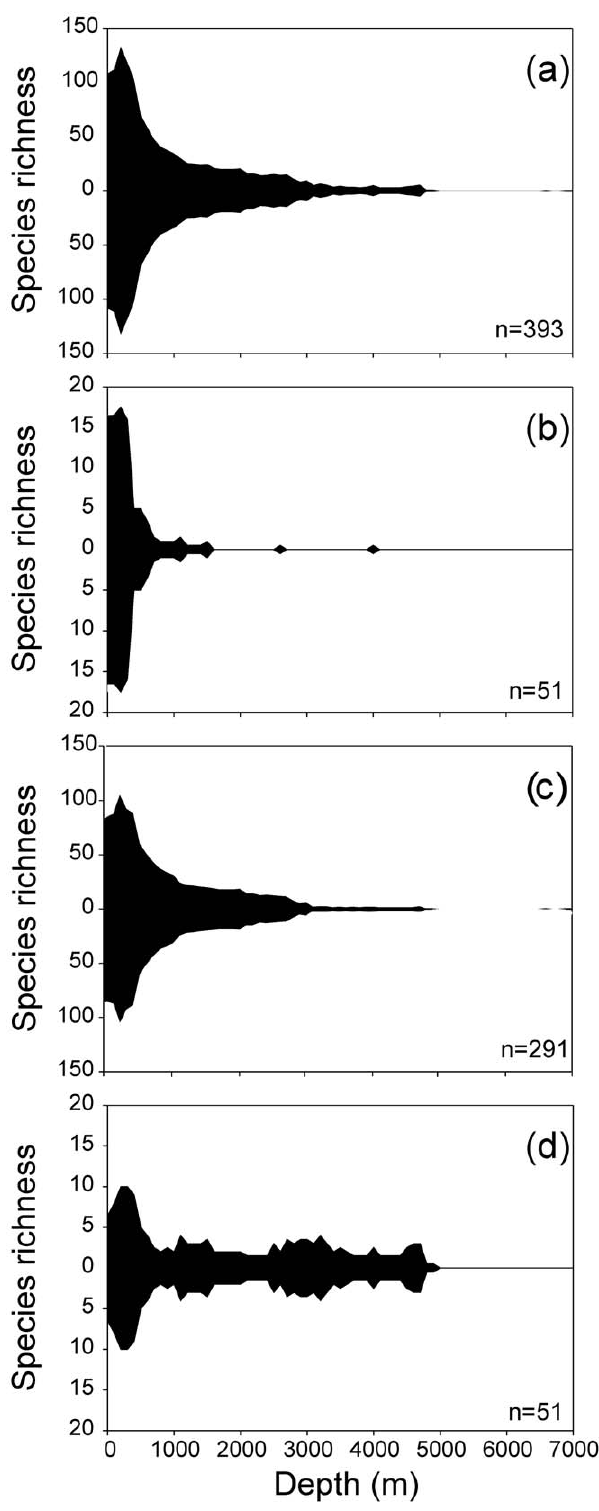
Figure 6. Depth distributions of sponges in the Southern Ocean. All Porifera (a), and each class of Porifera: Calcarea (b), Demospongiae (c), and Hexactinellida (d).